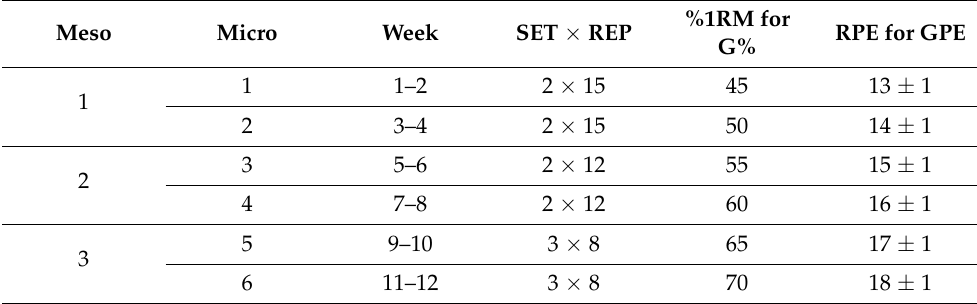
Table 2. Training volumes and intensities for G% (% 1RM) and GPE (Rating Perceived